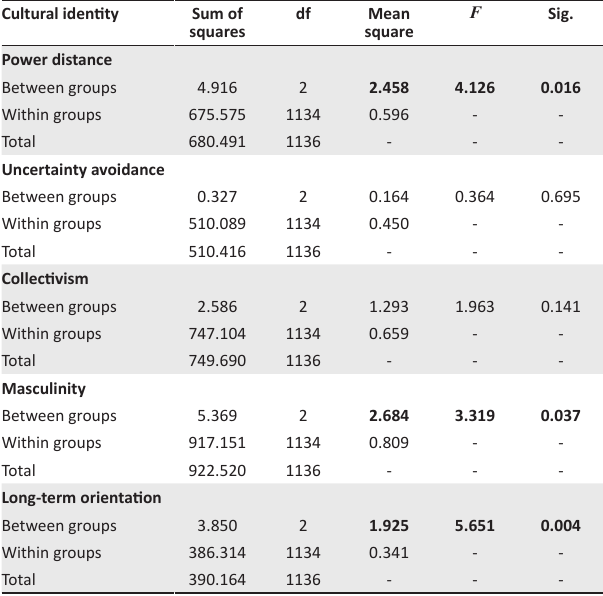
TABLE 7: One-way analysis of variance mean and p -value.